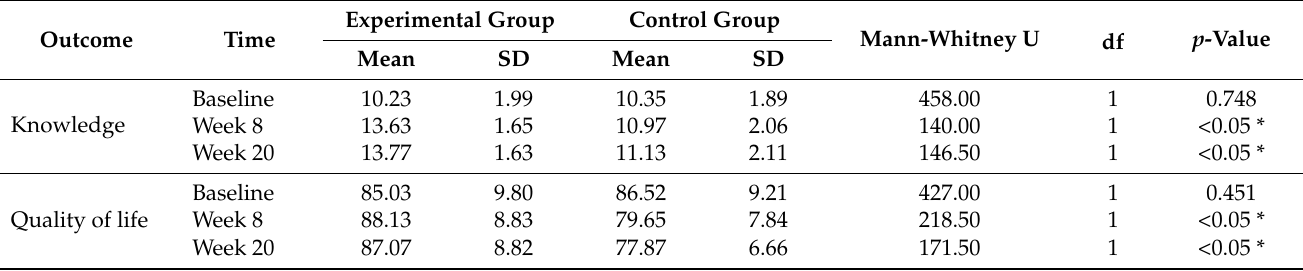
Table 6. Comparison of knowledge and quality of life scores between the experimental and control groups for the baseline, at the end of the program (week 8), and at the follow-up (week 20) ( n = 30). Experimental Group Control Outcome Time